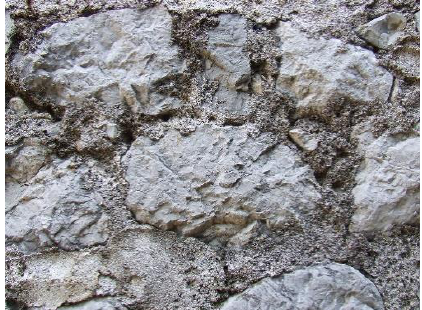
Figure 20. Less regular shaped blocks on the lateral façade from Strp and Lipci quarries. Figure 20. Front façade walls were built using the highly regarded fine stone from Strp and Lipci